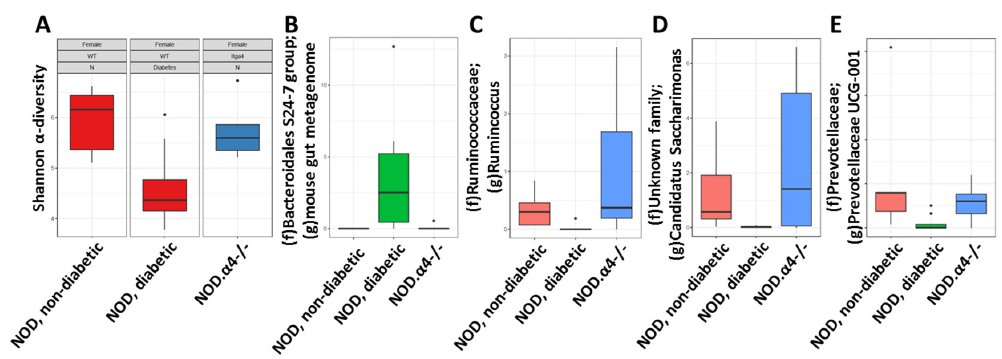
Figure 5. Microbiota analysis. Feces from 5 non-diabetic NOD, 5 NOD. α 4- / - and 9 diabetic NOD mice were subjected to microbiota analyses. Microbiota diversity of diabetic mice was restricted (Shannon α -diversity p < 0.05 diabetic NOD compared to both non-diabetic groups; p = n.s. between non-diabetic NOD and NOD. α 4- / -) ( A ) and marked by appearance ( B ), extinction ( C , D ) or quantitative depletion ( E ) of unique taxa (ANCOM score ≥ 0.7 for all four; box plot marking interquartile range and median; Dots mark outlier).